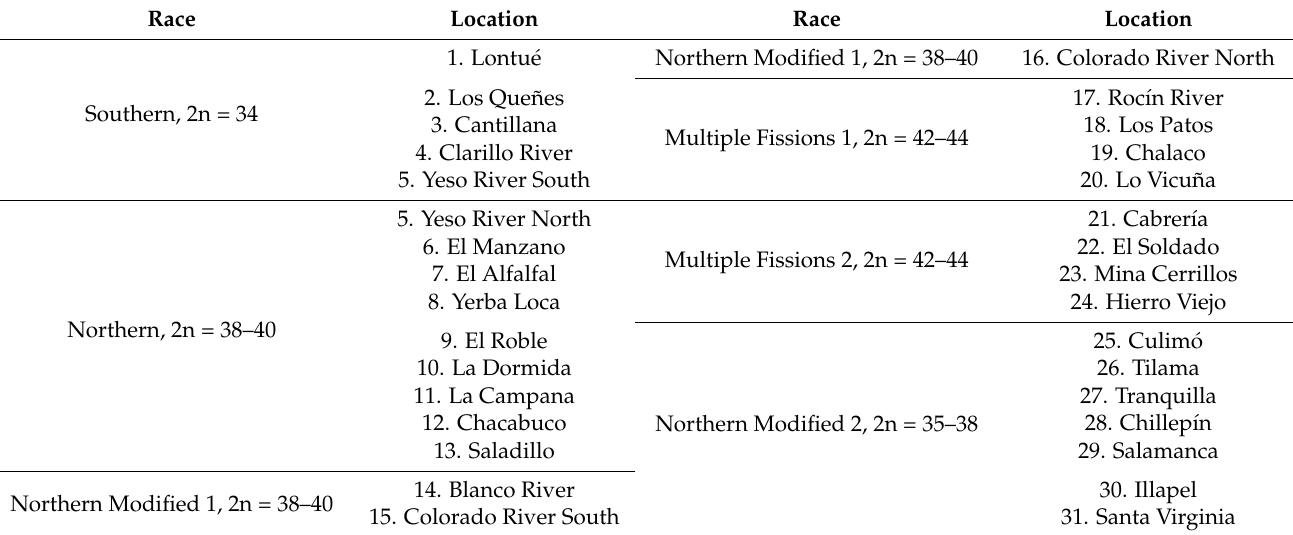
Table 1. Sampling locations for the different races of L. monticola . See Table S1 for a full list of sampled individuals. Race Location Race